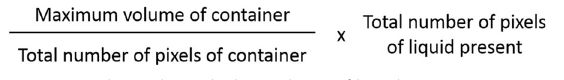
Fig. 3 Formula used to calculate volume of liquid present